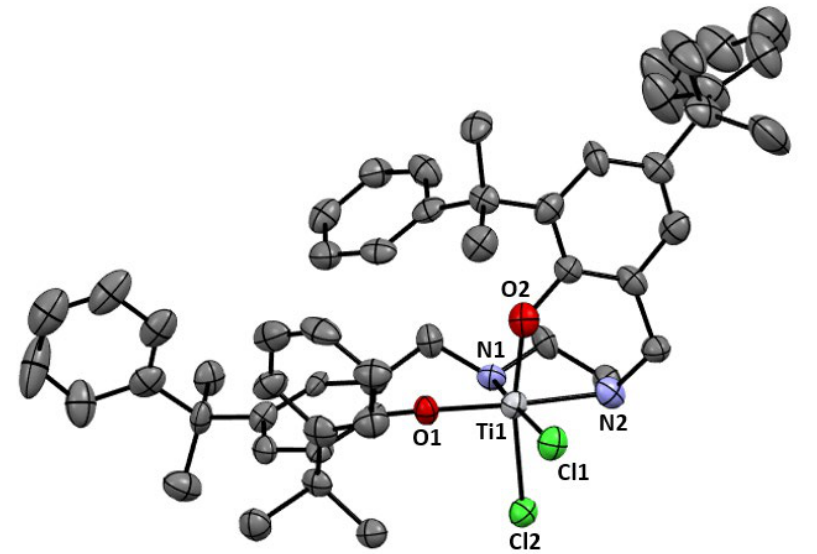
Figure 1. ORTEP diagram of [(H 2 N 2 O 2 )TiCl 2 ], 4 , showing thermal ellipsoids at 35% probability level. Hydrogens atoms and co-crystallized solvent molecules were omitted for clarity. Selected bond lengths (Å) and angles (°): Ti(1)-N(1) 2.193(8), Ti(1)-N(2) 2.219(9), Ti(1)-O(1) 1.827(6), Ti(1)-O(2) 1.811(8), Ti(1)-Cl(1) 2.306(3), Ti(1)-Cl(2) 2.407(3); N(1)-Ti(1)-N(2) 75.6(3), N(1)-Ti(1)-O(1) 84.6(3), N(2)-Ti(1)-Cl(1) 96.2(2), O(1)-Ti(1)-Cl(1) 103.3(2), O(2)-Ti(1)-Cl(2) 166.3(2). Complexes 4 and 5 display distorted octahedral geometries around titanium